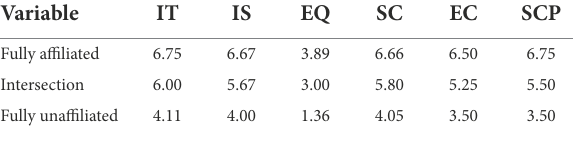
TABLE 3 Calibration values for each